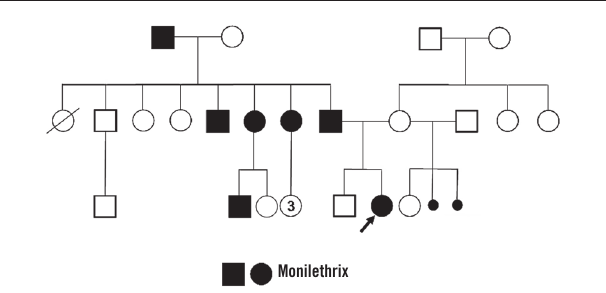
figurE 1 − Pedigree showing individuals of the family affected by monilethrix (the patient is indicated by the arrow), in an autosomal dominant pattern of inheritance